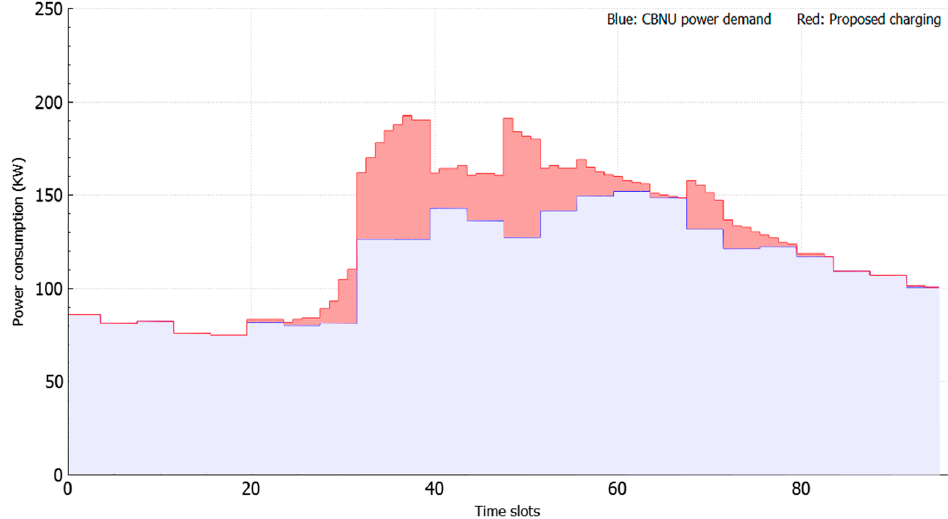
Figure 7. Results of scenario two with proposed coordinated charging.